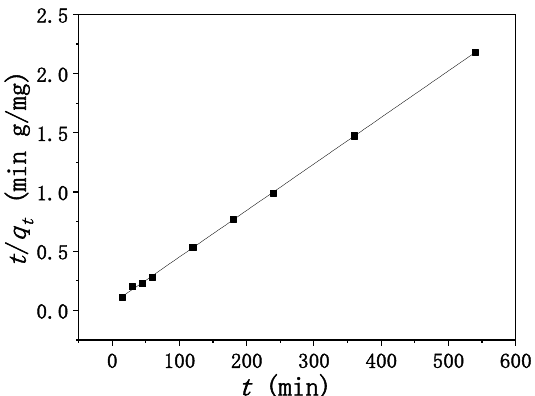
Figure 6. The change curve of adsorption performance of NiCo 2 O 4 /MWCNTs with time. Tempera- ture, 25 °C; C 0 , 150 mg L − 1 ; pH, 5.0; the mass of NiCo 2 O 4 /MWCNTs, 0.01 g.